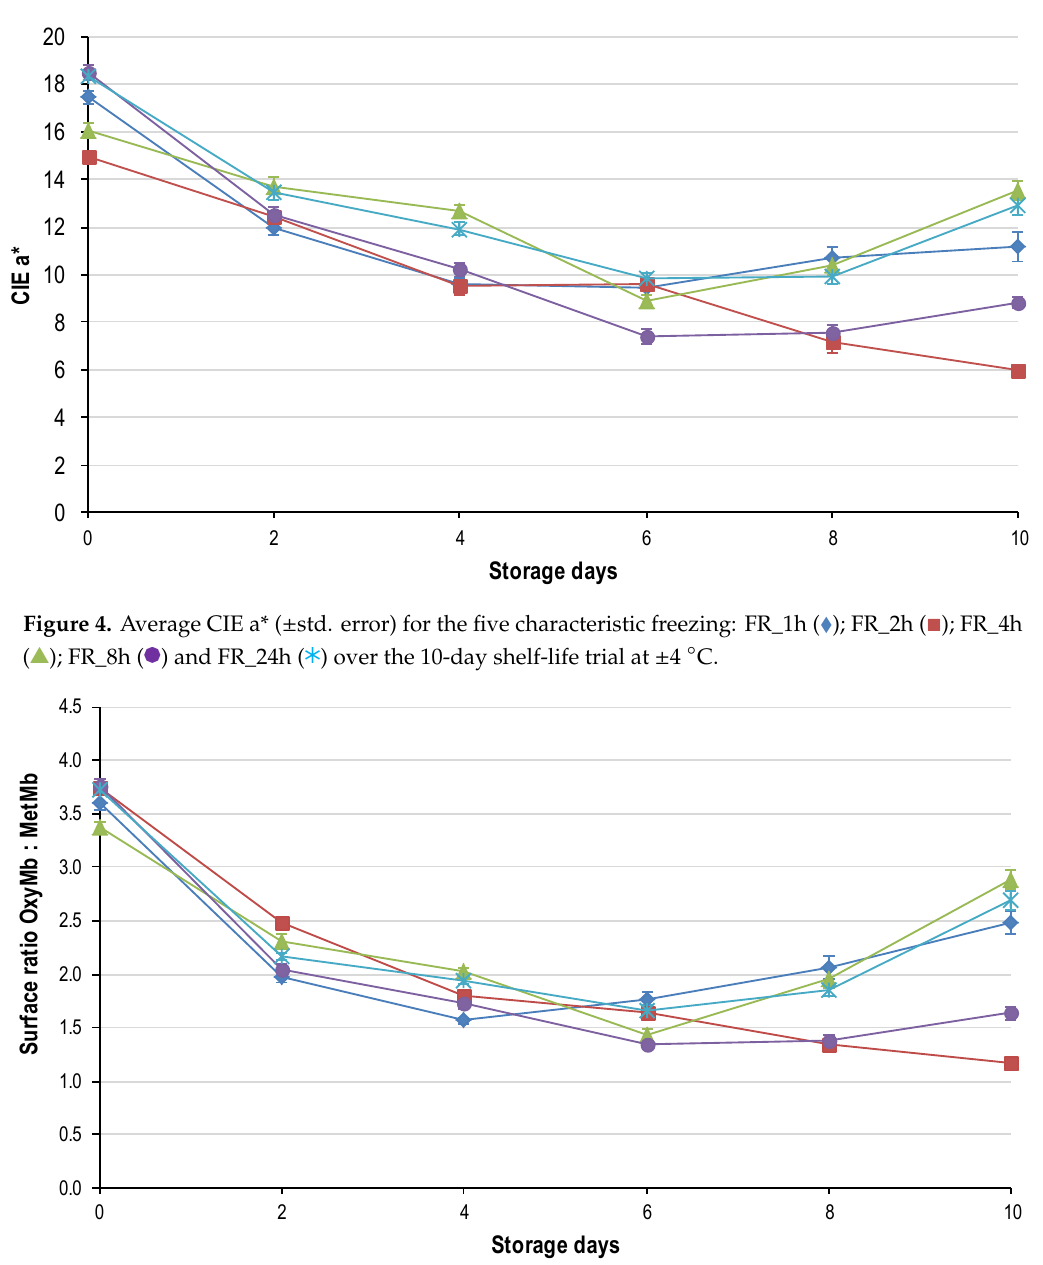
. Figure 2. Average cooking loss (±std. error) for the five characteristic freezing rates: FR_1h (  ); FR_2h Figure 2. Average cooking loss (±std. error) for the five characteristic freezing rates: FR_1h (  ); FR_2h Figure 2. Average cooking loss (±std. error) for the five characteristic freezing rates: FR_1h (  ); FR_2h Figure 5. Ratio oxymyoglobin (OMb) / metmyoglobin (MMb) ( ± std. error) for the five characteristic Figure 5. Ratio oxymyoglobin (OMb)/metmyoglobin (MMb) (±std. error) for the five characteristic (  ); FR_4h (  ); FR_8h (  ) and FR_24h (  ) over the 10-day shelf-life trial at ±4 °C. (  ); FR_4h (  ); FR_8h (  ) and FR_24h (  ) over the 10-day shelf-life trial at ±4 °C. (  ); FR_4h (  ); FR_8h (  ) and FR_24h (  ) over the 10-day shelf-life trial at ±4 °C. freezing rates: FR_1h ( (cid:7) ); FR_2h ( (cid:4) ); FR_4h ( trial at ± 4 ◦